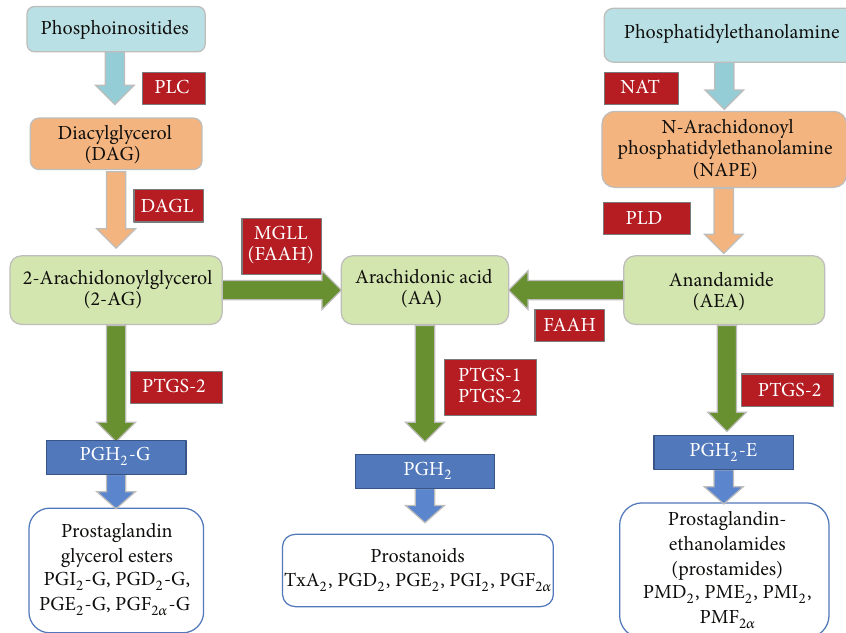
Figure 1: Endocannabinoid system giving rise to endocannabinoids (2AG and AEA) and arachidonic acid and subsequently synthesis of prostaglandin glycerol esters, prostanoids, and